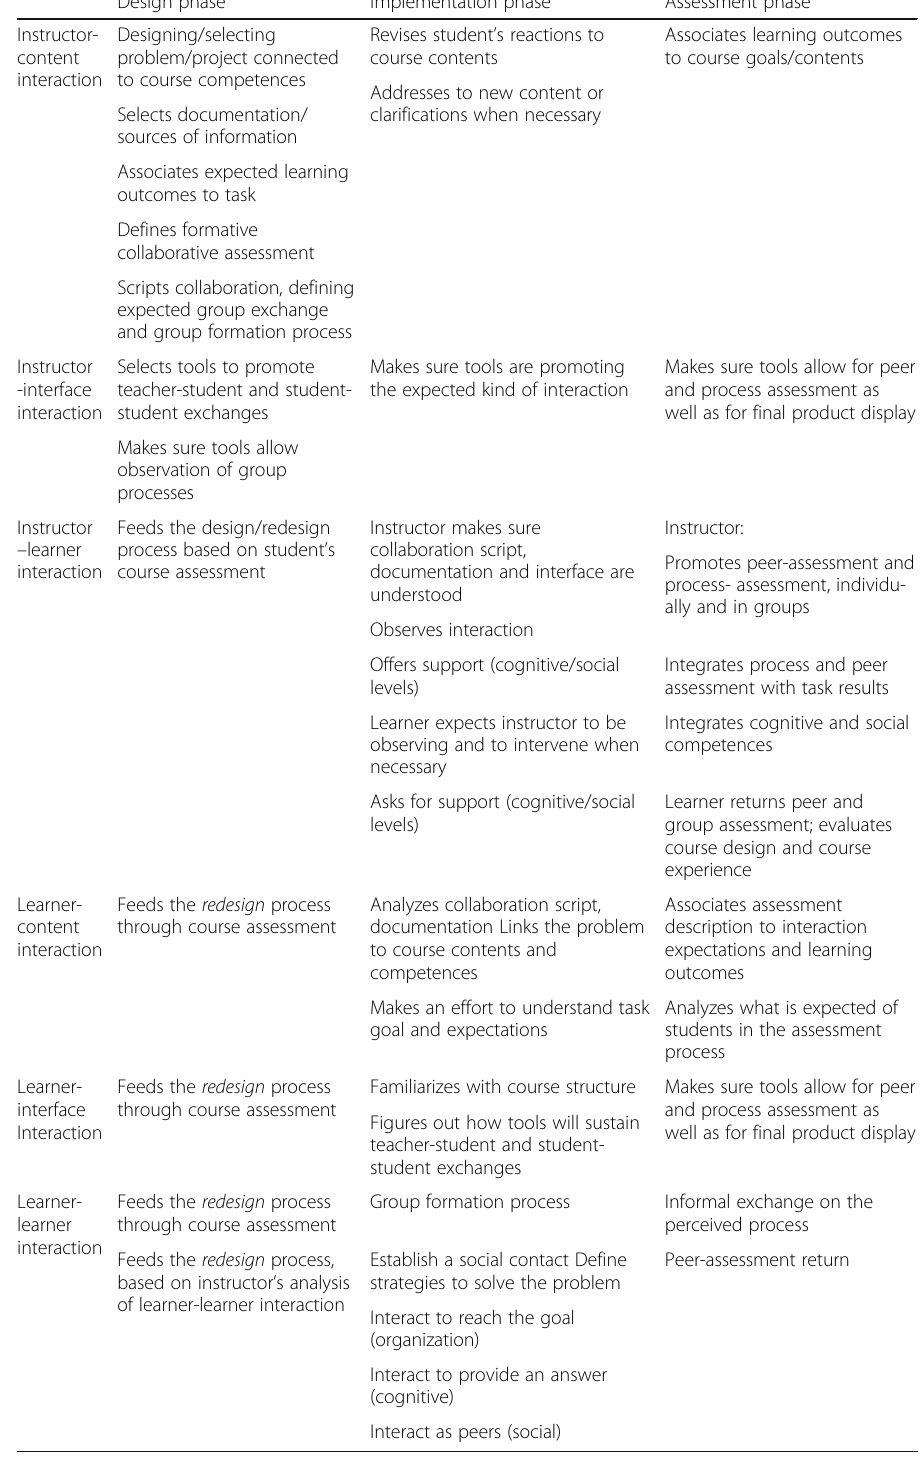
Table 1 Design, Implementation and Assessment phases associated with interaction